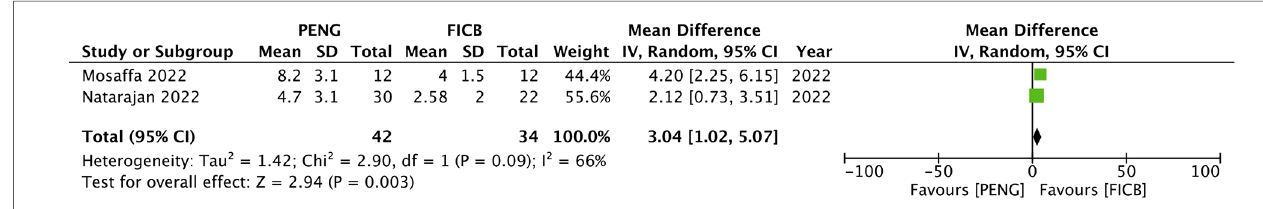
FIGURE 4 Meta-analysis of time to fi rst analgesic request between PENG and FICB groups.